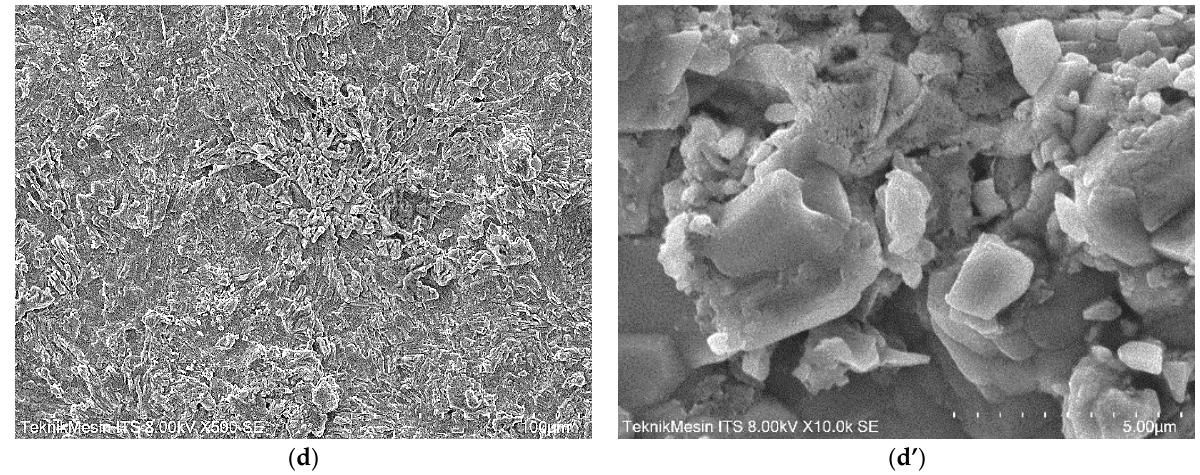
Figure 10. SEM images of the outer layers at two difference magnifications, 500× and 8000× for each sample: ( a , a’ ) Geopolymer, ( b , b’ ) Geo–TiO 2 (3), ( c , c’ ) Geo–rGO–TiO 2 (0.5, 3), ( d , d’ ) Geo–rGO–TiO 2 (1, 3). Red circles in sample geopolymer indicate the unreacted metakaolin.